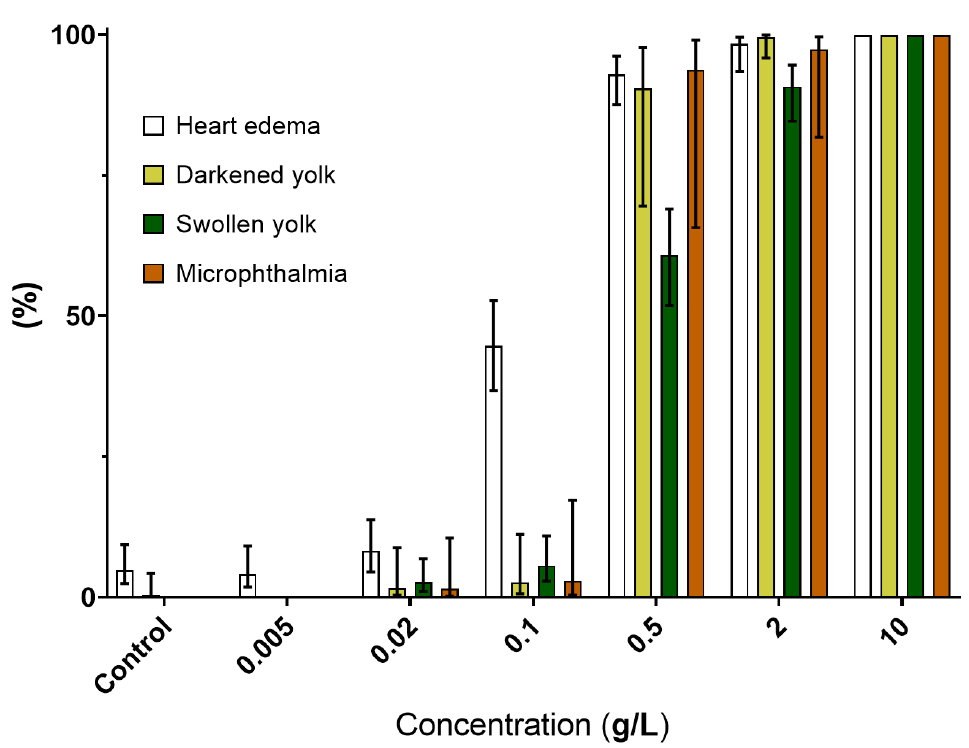
Figure 6. Prominent defects after four days of QY treatment to zebrafish embryos. Error bars showing 95% prediction interval.